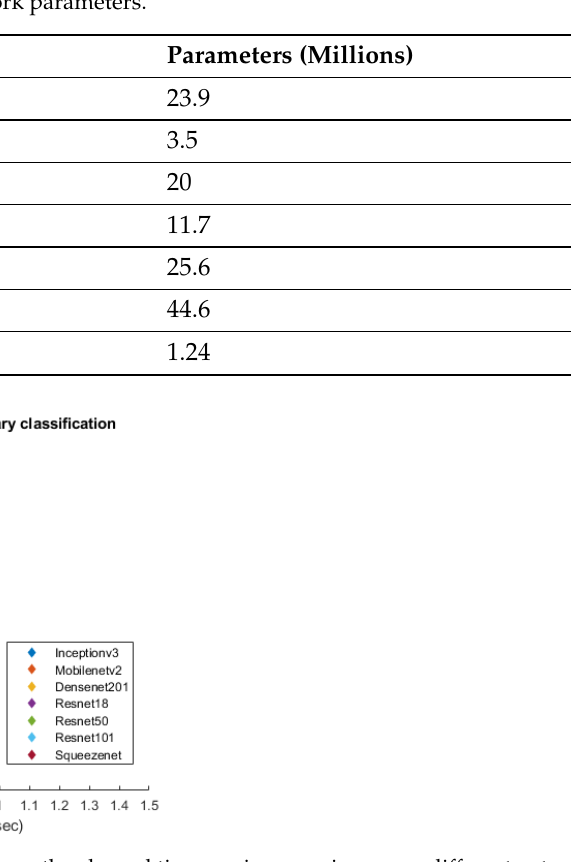
Figure 11. Comparison of accuracy versus the elapsed time per image using seven different networks for thalassaemia